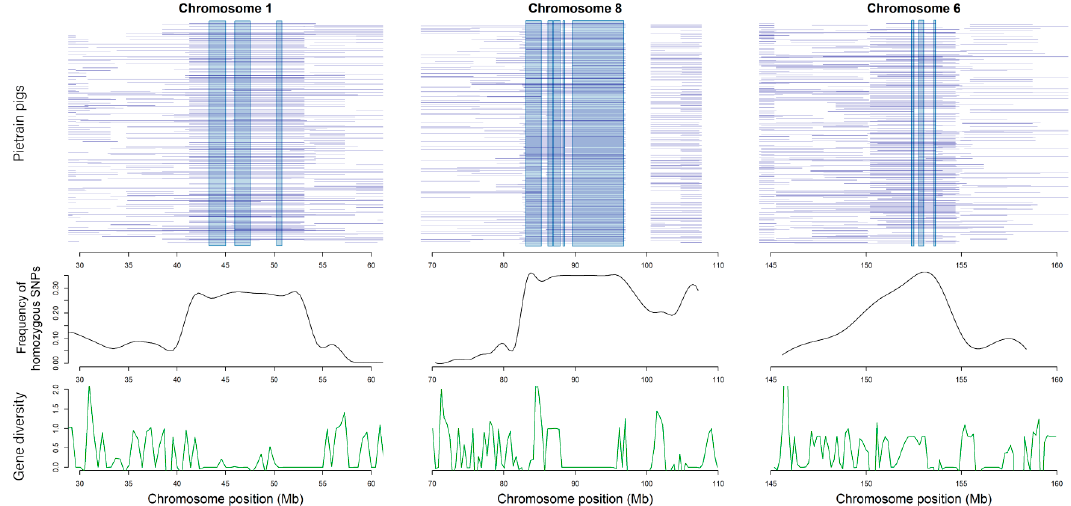
Figure 4. The distribution of ROH core regions in chromosome 1, 8 and 6, the allele frequency and gene diversity in each SNP among the corresponding regions. Blue horizontal lines represent distribution of ROH of per individual. Black line represents frequency of homozygous SNPs averaged in each step of 100Kb. Green line represents gene diversity per SNP.